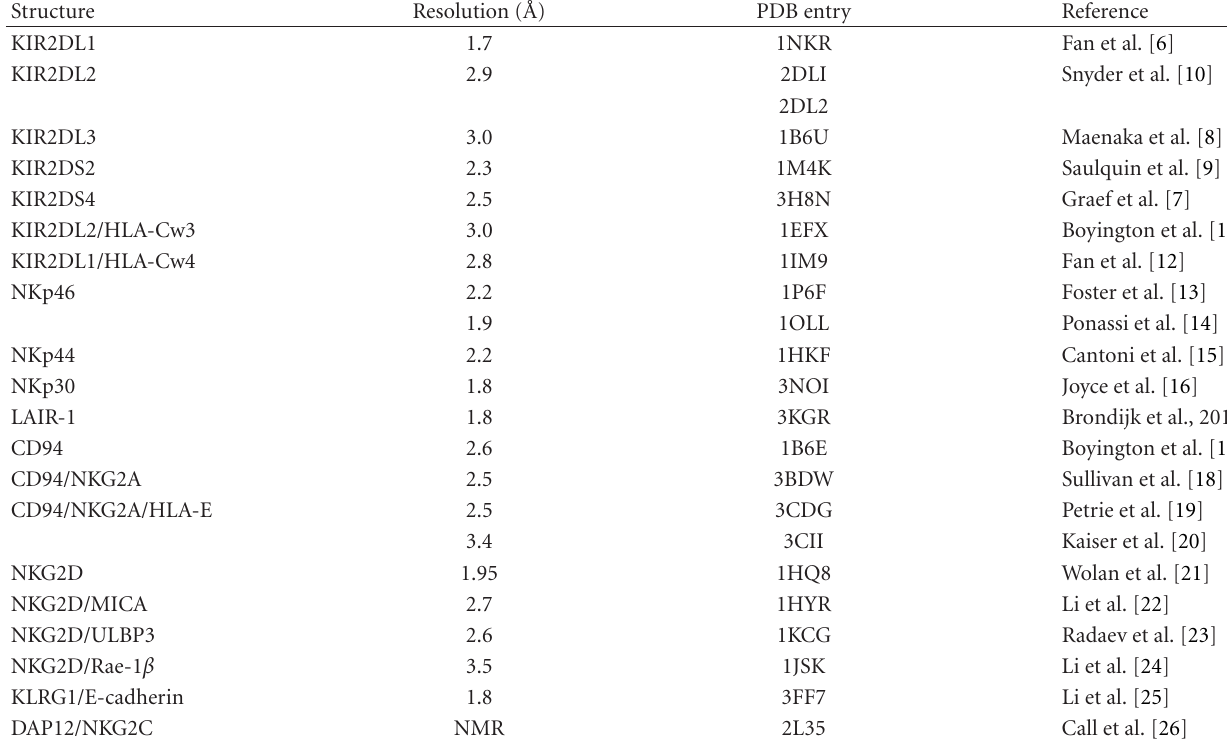
Table 1: List of human NK receptor